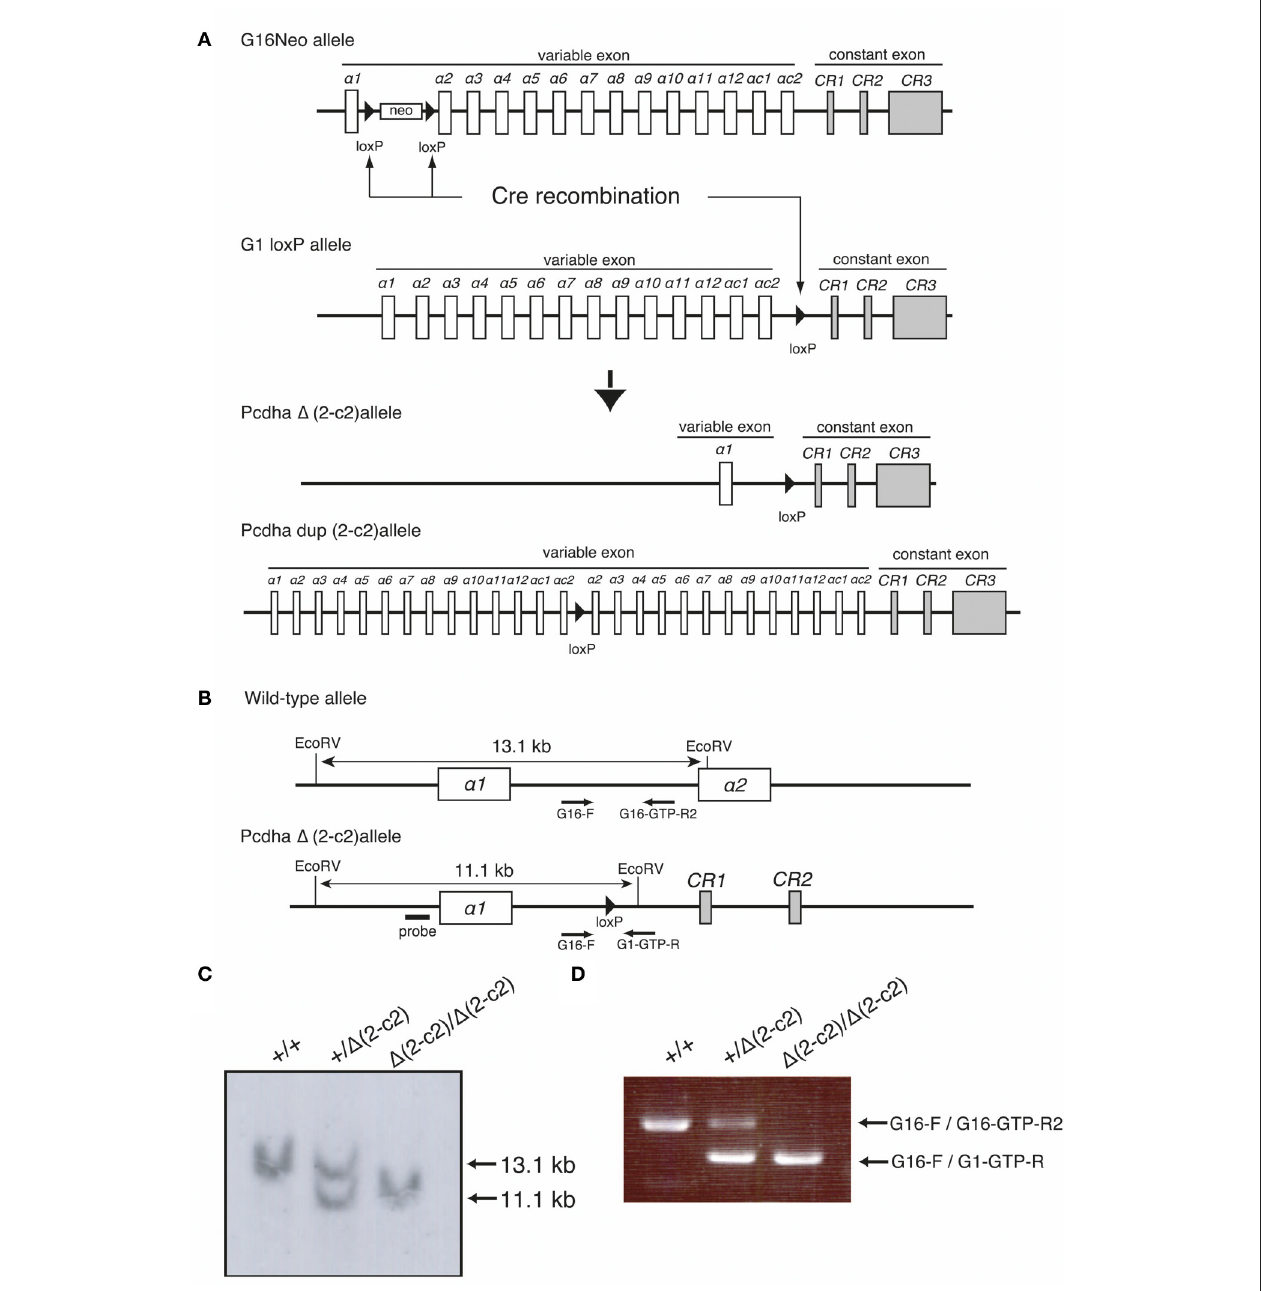
FIGURE 5 | Generation of the Pcdha (cid:2)( 2–c2 ) and Pcdha dup ( 2–c2 ) alleles in mice. (A) Pcdha (cid:2)( 2–c2 ) and Pcdha dup ( 2–c2 ) mice were generated by mating G16Neo mice, G1 loxP mice, and Sycp-Cre transgenic mice created by synaptosomal-Cre (TAMERE) system in the testis. This Cre is expressed